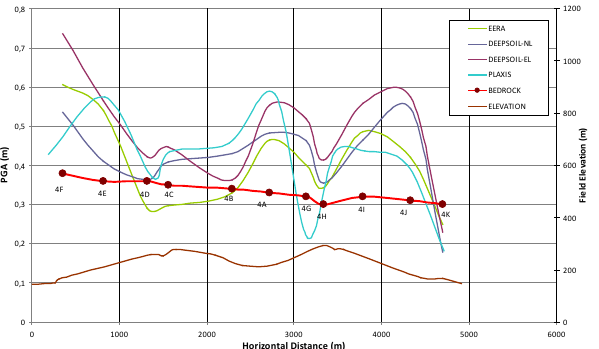
Figure 13. Change in the peak ground acceleration on the surface for the 4-4’ section. In section 4, it is observed that the results of the one and two dimensional analyses are more compatible in comparison to the other sections. In the two-dimensional analysis, the beginning of the graph is just the opposite to the sections but as in accordance with the one- dimensional analyses. This difference that occurs at the beginning results from the calculations of the Plaxis program under the initial limit conditions. The values between the 4E and 4D points where the field topographical incline increases from left to right sharply declines in each of the three graphs. It is thought that the parameter effective in the one- dimensional analysis is the Bakırköy limestone located at the upper levels of the section and gradually thickening. Between points 4D and 4C the surface topography and the thicknesses of Bakırköy limestone levels change and their effect is again observable in the results of the three analyses. However, the EERA results fall below the bedrock peak acceleration values until the 4B point, that is, the end of the Bakırköy formation. Between points 4B and 4A where the old stream bed is situated at the bottom of the valley and the alluvial layer is